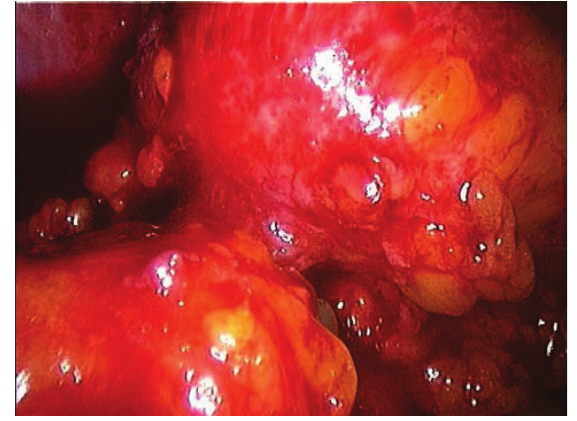
Figure 2. Fistulous tract between sigmoid colon and bladder that was carefully isolated.